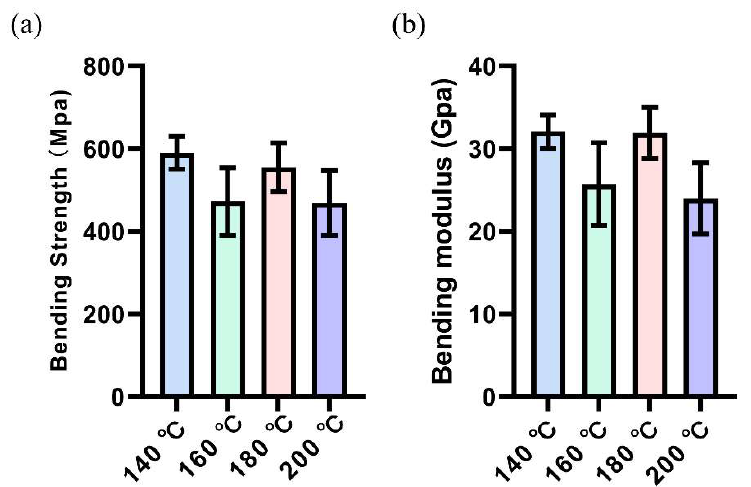
Figure 8. ( a ) Bending strength; ( b ) modulus of CFRPs molded at different temperatures.